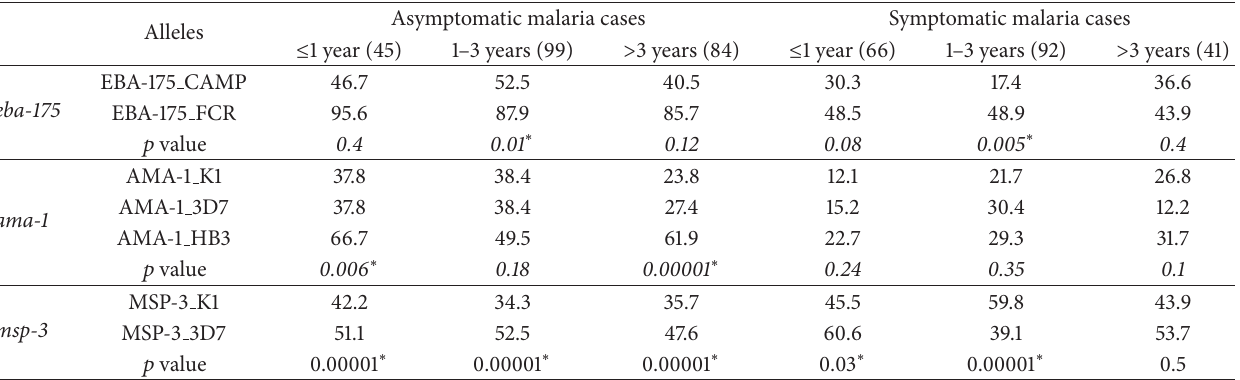
Table 3: Age variation of eba-175 , msp-3 , and ama - 1 allele prevalence. Asymptomatic malaria Alleles